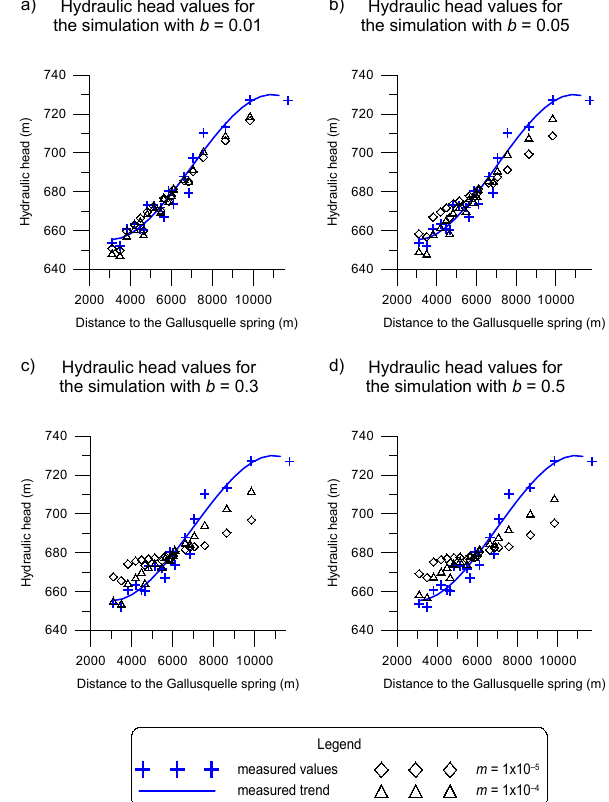
Figure 2. Hydraulic head distributions for different combinations of geometric conduit parameters for scenario 1. b is the lowest conduit radius and m the radius increase along the conduit. For comparison, a trend line is fitted to the measured hydraulic head values showing the distribution of hydraulic gradients from the Gallusquelle spring to the western border of its catchment